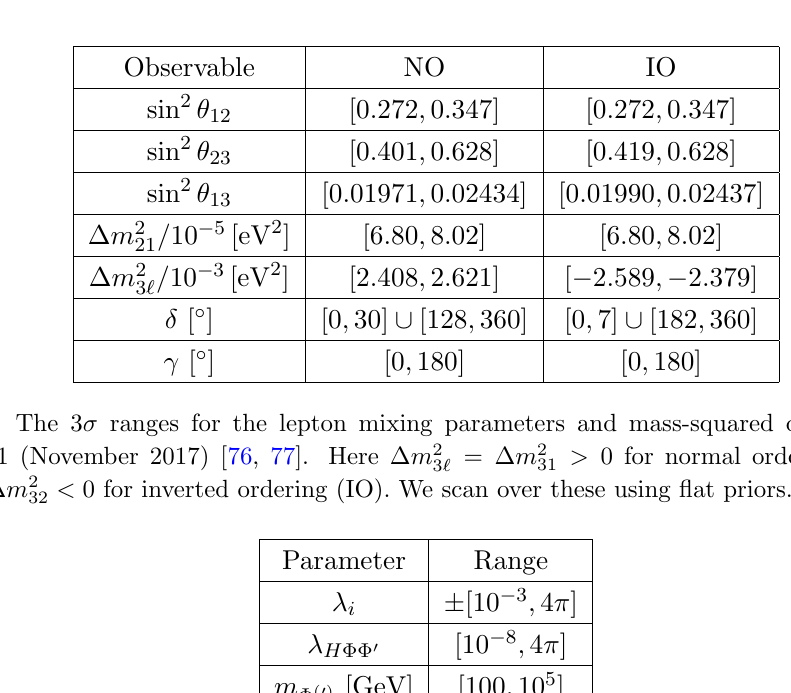
Table 3 . Priors on the 12 free real parameters used in the scan. (cid:21) i includes the following 8 quartic couplings of the potential: (cid:21) in appendix C. We scan over these parameters using logarithmic priors.